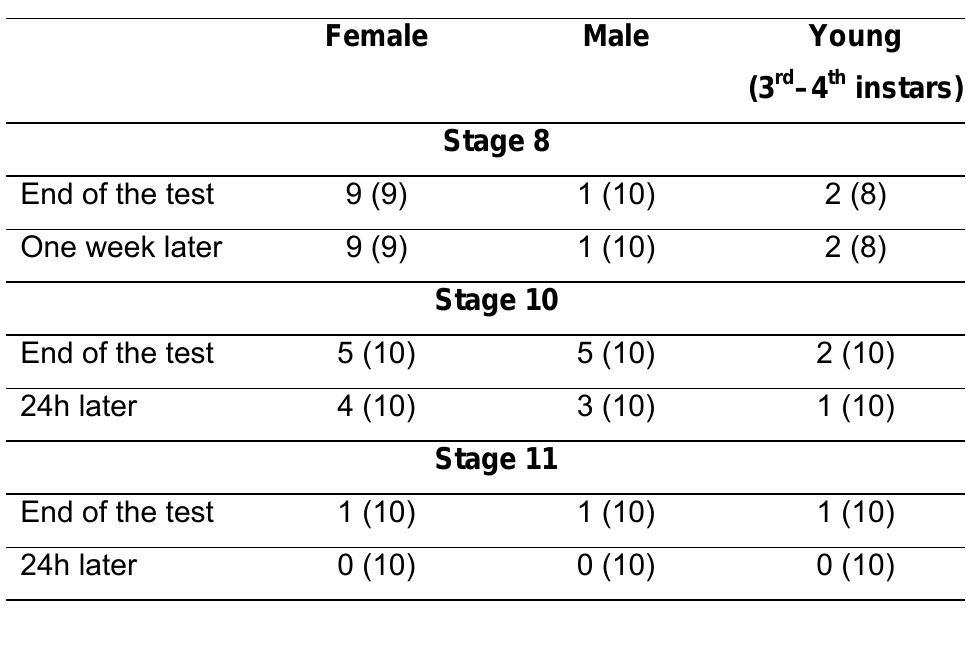
Table 1. Number of live Loxosceles intermedia at the end of experimental stages 8, 10 and 11. Total number of individuals included in each sample is shown in